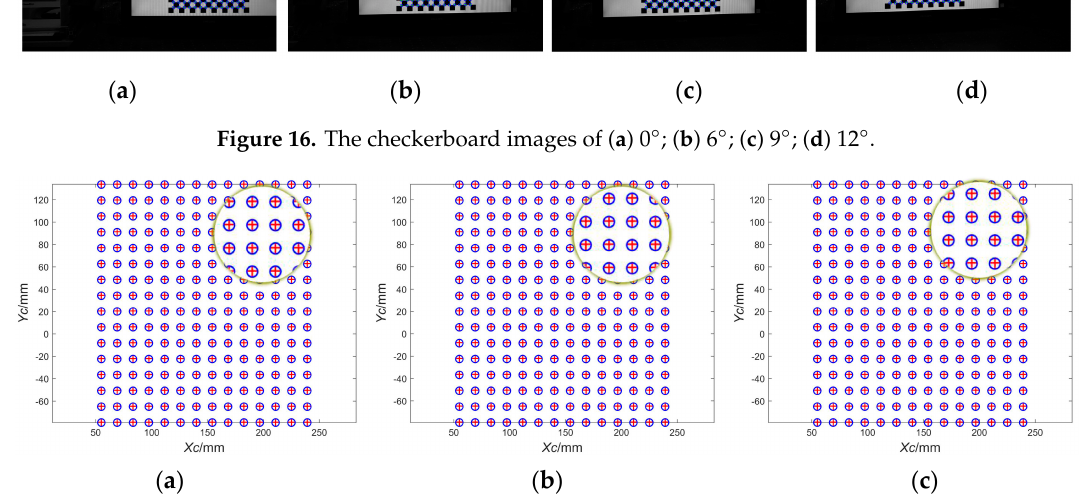
Figure 17. The comparative diagrams of the marked points of ( a ) 6 ◦ ; ( b ) 9 ◦ ; ( c ) 12 ◦ . Table 6. The standard deviation in the X c and Y c directions.